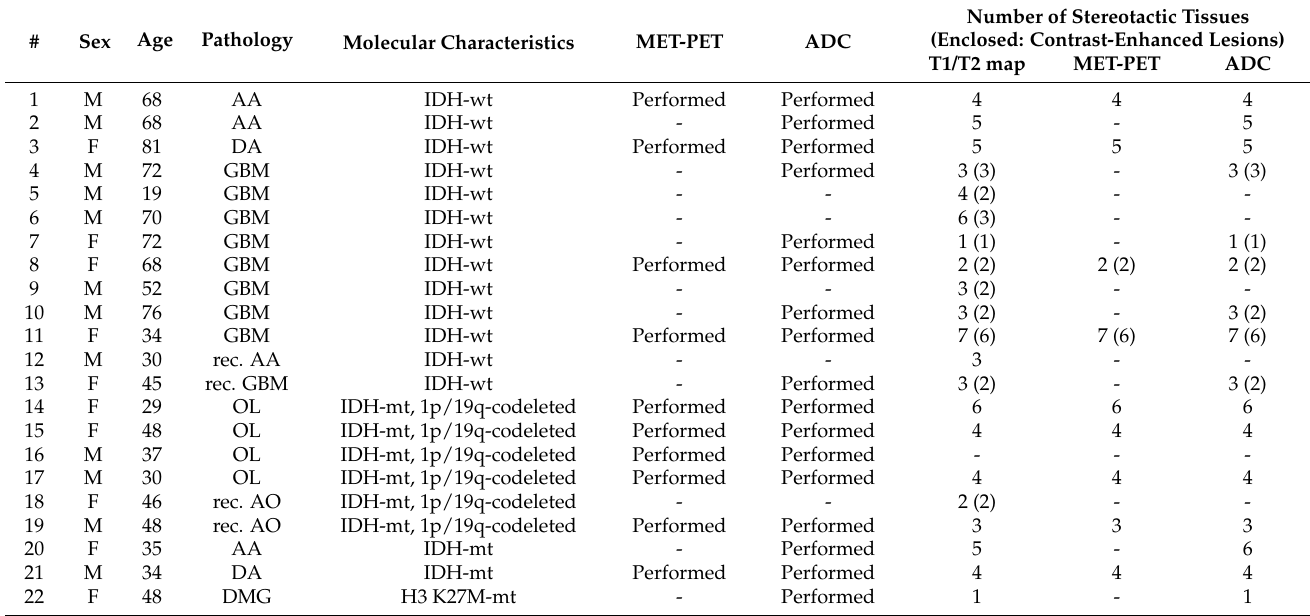
rec. = recurrent, AA = Anaplastic astrocytoma, DA = Diffuse astrocytoma, GBM = Glioblastoma, OL = Oligodendroglioma, AO = Anaplastic oligodendroglioma, DMG = Diffuse midline glioma, wt = wildtype, mt = mutant, MET-PET = 11 C-methionine positron emission tomography, ADC = apparent diffusion